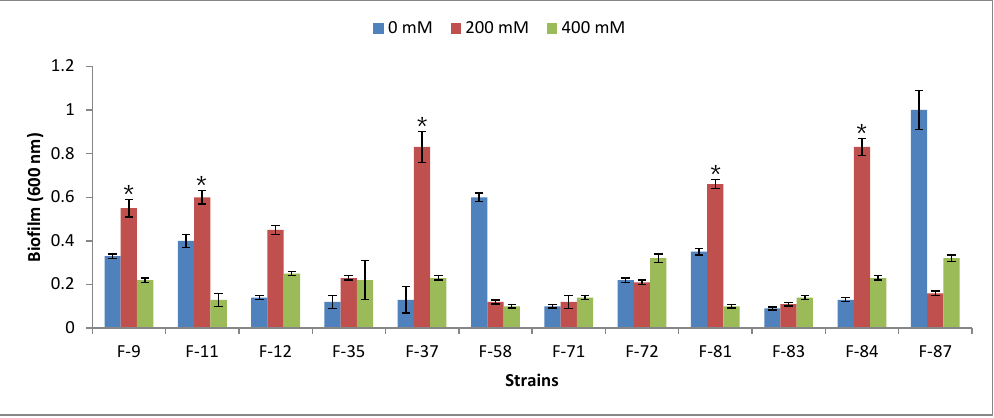
Figure 4. Effect of different NaCl concentrations on biofilm-forming ability of bacterial strains. Bars represent mean ± SE of three replicates. Treatments followed by * indicate significant difference over control using Duncan’s multiple range test ( p ≤ 0.05).